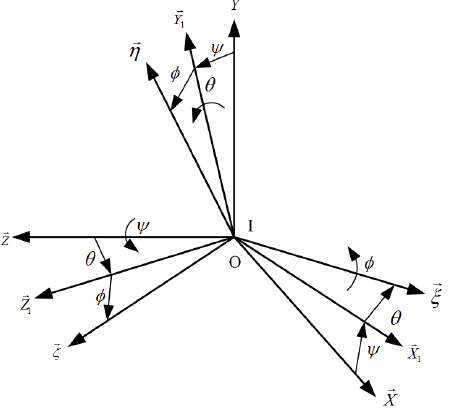
Figure 3. The coordinate transformation figure.